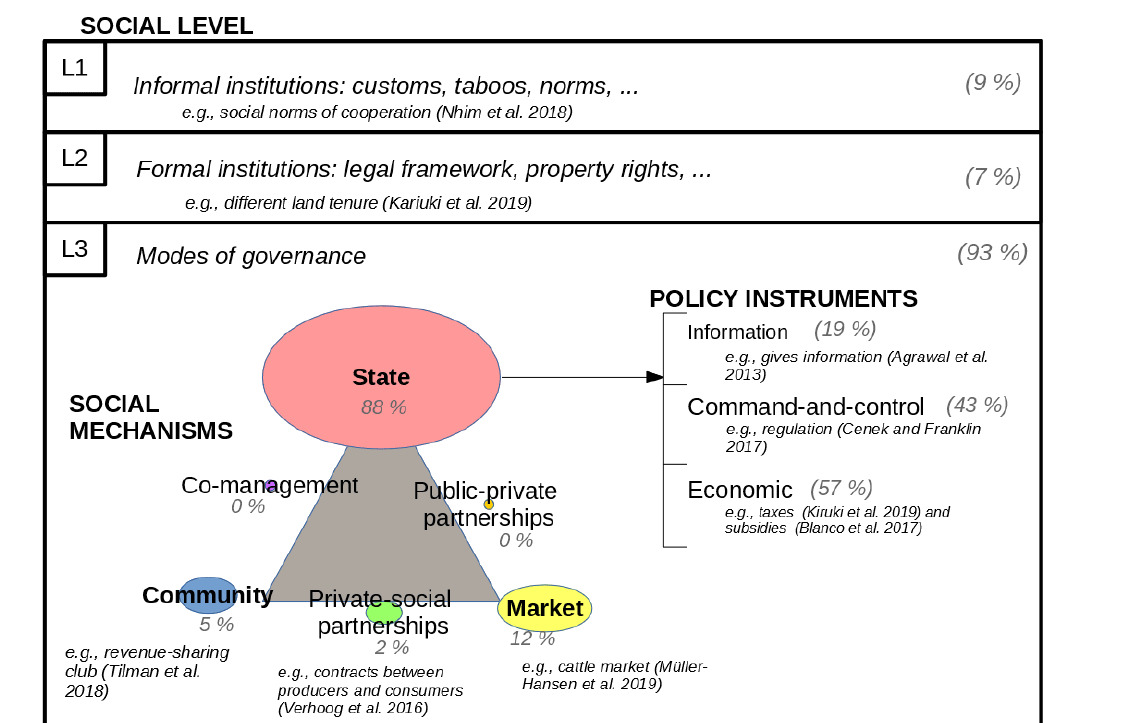
Fig. 2 . Typology of governance and examples from the review of the literature: three levels of governance analysis. The size of the circles depends on the representation of the mode in the articles reviewed. Bold type indicates the main modes and normal type, the hybrid form. Percentages do not necessarily add up to 100% because one paper may use several categories at the same time. Adapted from Williamson (2000), Lemos and Agrawal (2006), Driessen et al. (2012), and Villamayor-Thomas et al.